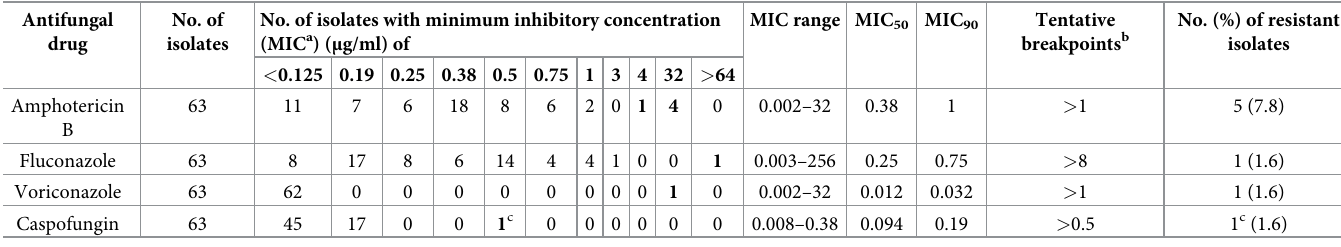
Table 3. In vitro susceptibilities of C . kefyr isolates to four antifungal agents as determined by Etest. Antifungal No. of drug